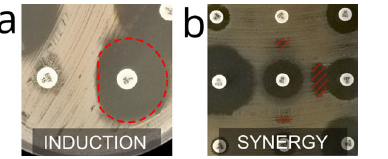
Fig. 7 Characteristic shapes of inhibition zones due to resistance mechanisms. a D-shape inhibition zone due to induction. b Appearance of inhibition between antibiotic disks due to